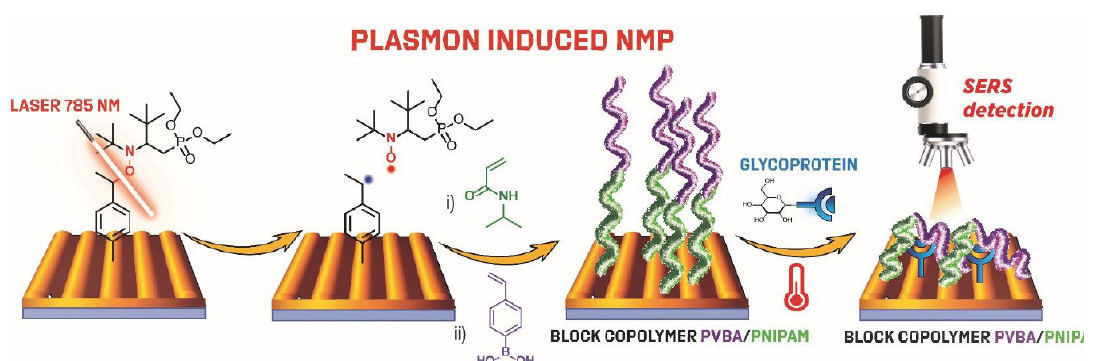
Figure 13. Scheme for plasmon-initiated NMP (PI-NMP). Reprinted with the permission of RSC from ref. [102].